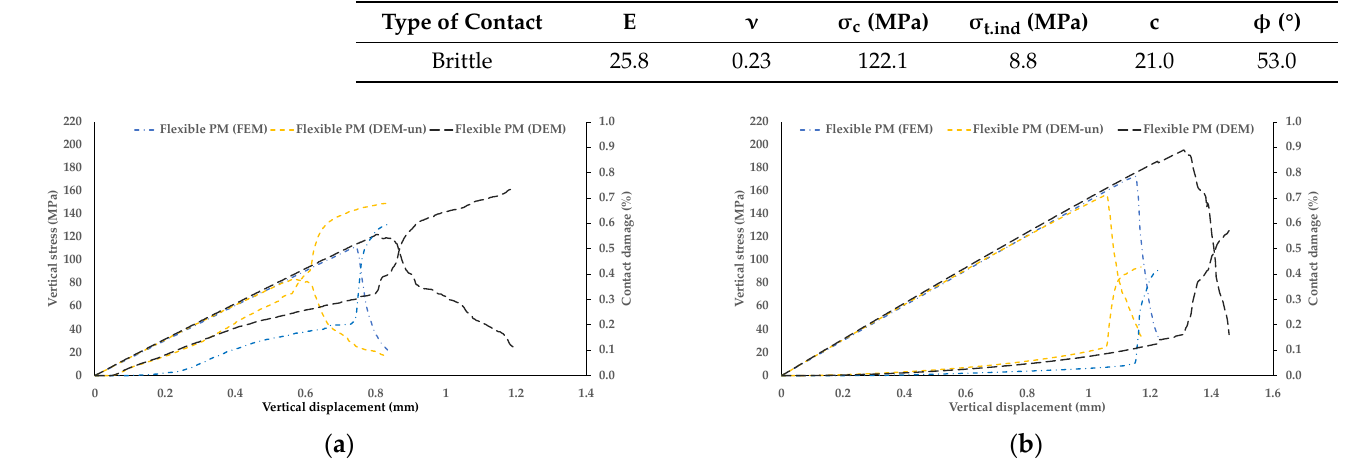
Table 3. Augig granite macro-properties [11,15].